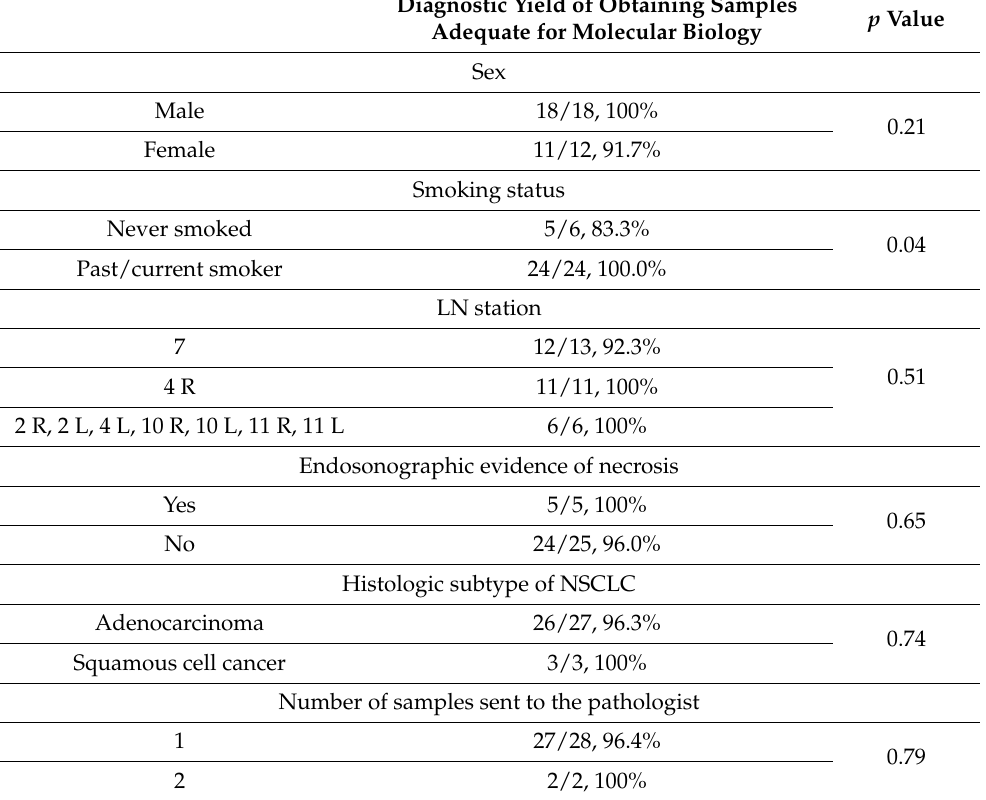
Table 2. Diagnostic accuracy of EBUS-TBNA with slow-pull capillary aspiration for molecular biology and PD-L1 testing in stratified analyses ( n =